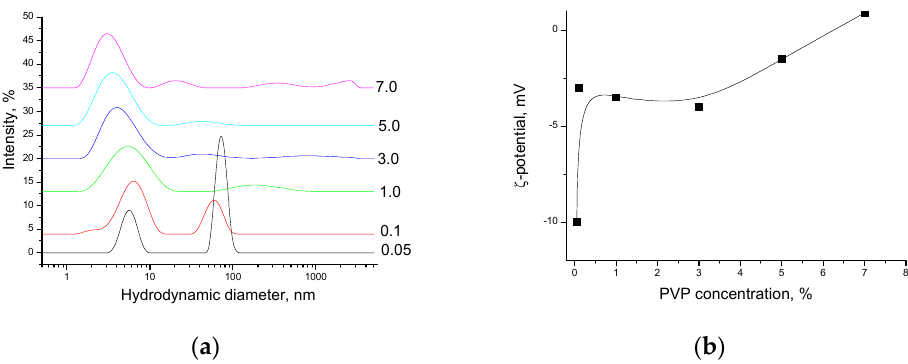
Figure 11. PVP particles size distribution (the curves are marked by PVP concentration in wt.%) ( a ) and the PVP particles surface charge in aqueous solutions ( b ).